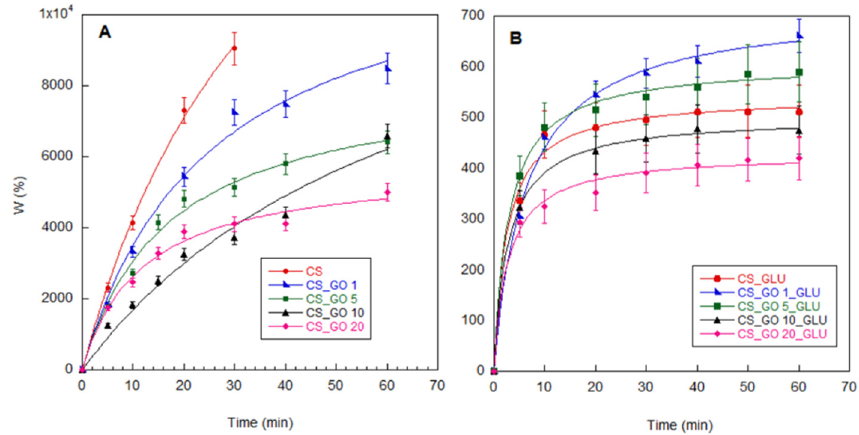
Figure 5. Water-uptake kinetics of non-crosslinked ( A ) and crosslinked ( B ) CS and CS_GOX composites.